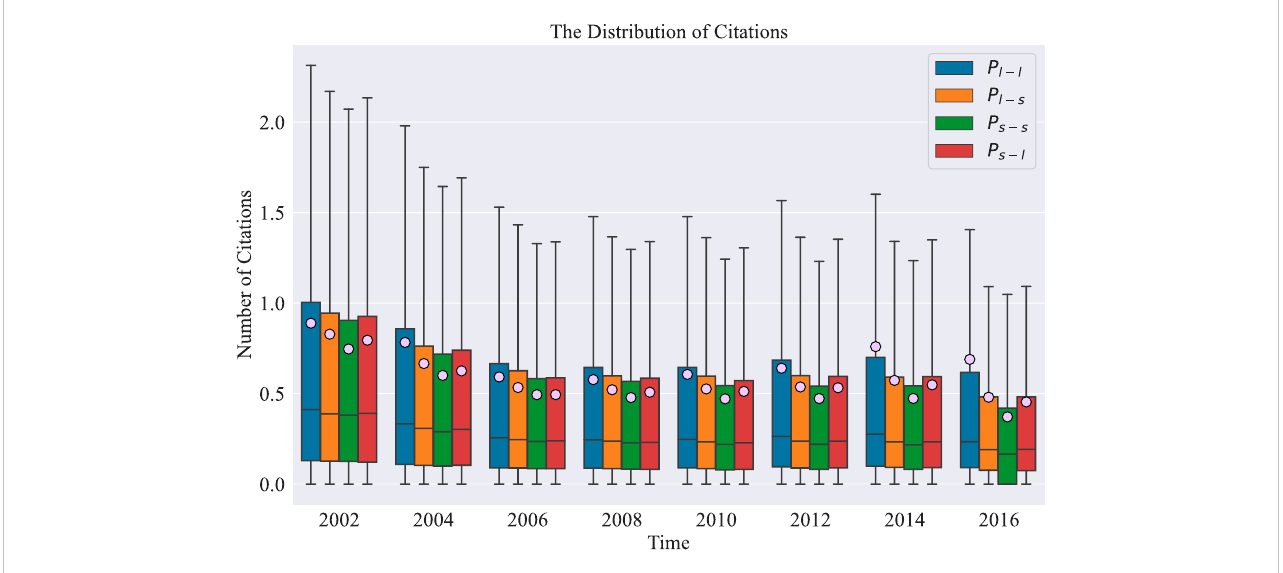
FIGURE 2 The evolution of citations of papers within different interdisciplinary types. We classify papers as the large discipline (blue box), the large across the small discipline (orange box), the small discipline (green box), and the small across large discipline (red box). The solid line and the pink dot in box represent the median and average number of citations,